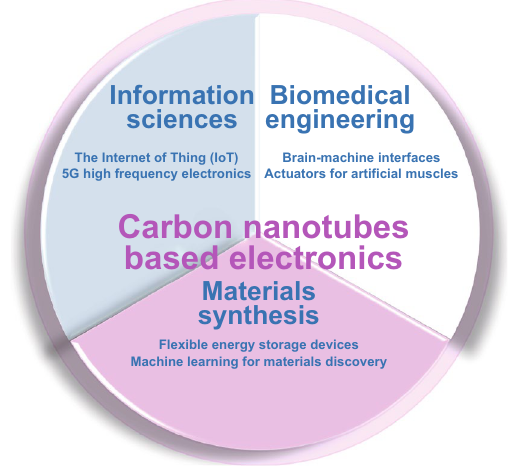
Fig. 1 The emerging applications of carbon nanotube-based